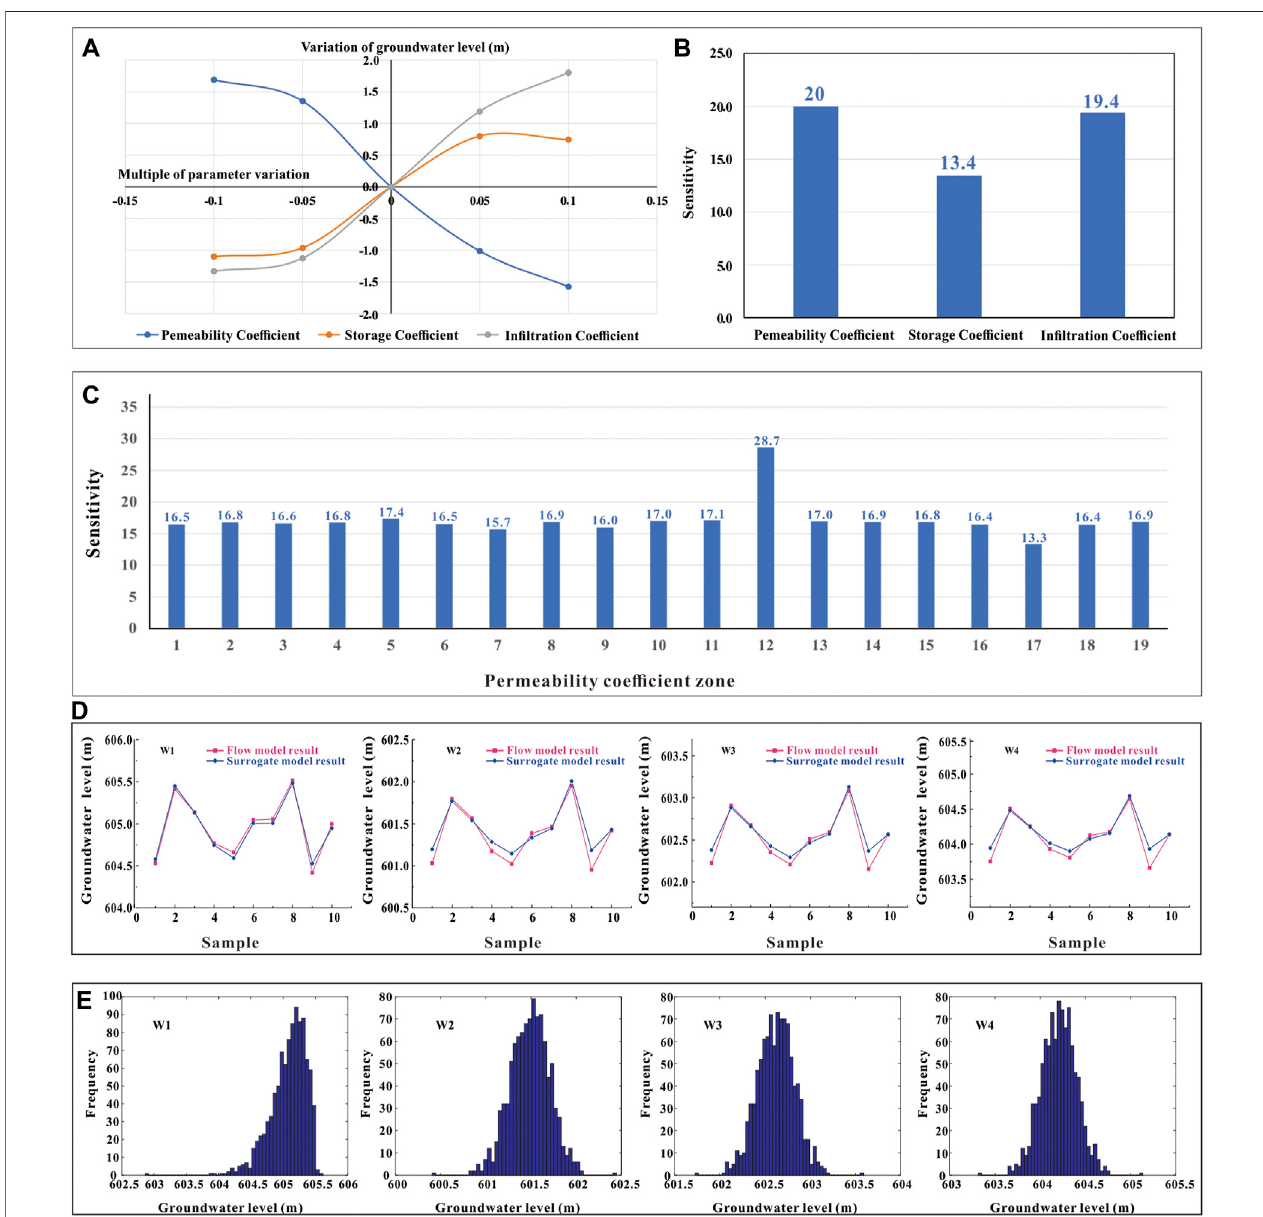
FIGURE10 |(A,B) . Groundwaterlevel variation diagram and sensitivity histogram. (C) .Sensitivity histogram ofall permeability coef fi cient zones. (D) .Fittingresults of groundwater levels of four virtual monitoring holes (W1, W2, W3, W4) between the 2,150 years ’ surrogate model and groundwater fl ow model. (E) . Frequency distributions of groundwater level terms by the 2150-years surrogate